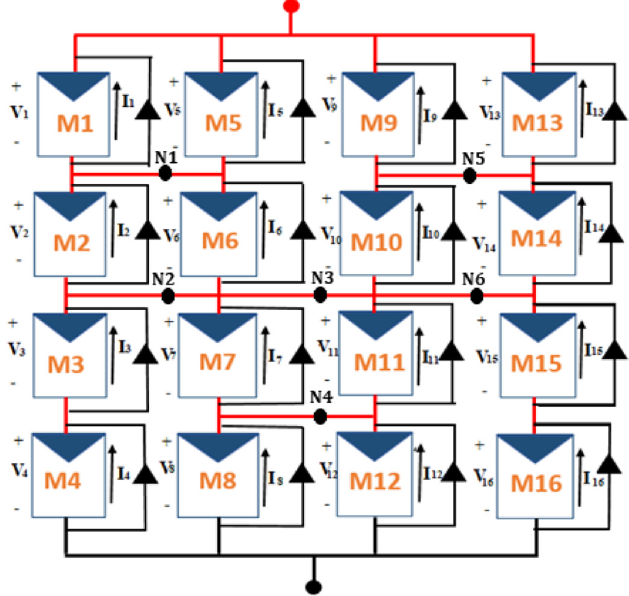
Fig. 8. HCTCT PV array con fi guration broader